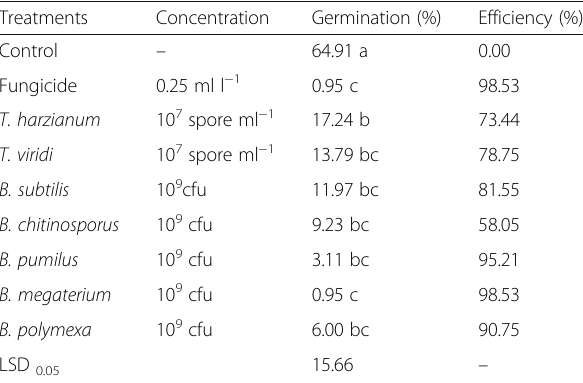
Values are means of three replicates of each treatment Means values for each parameter followed by different letters are significantly different ( P ≤ 0.05), according to Duncan ’ s multiple range